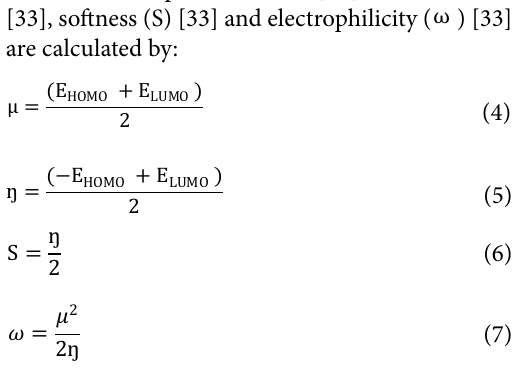
Fig. 2: Possible structures for ZnO, CO